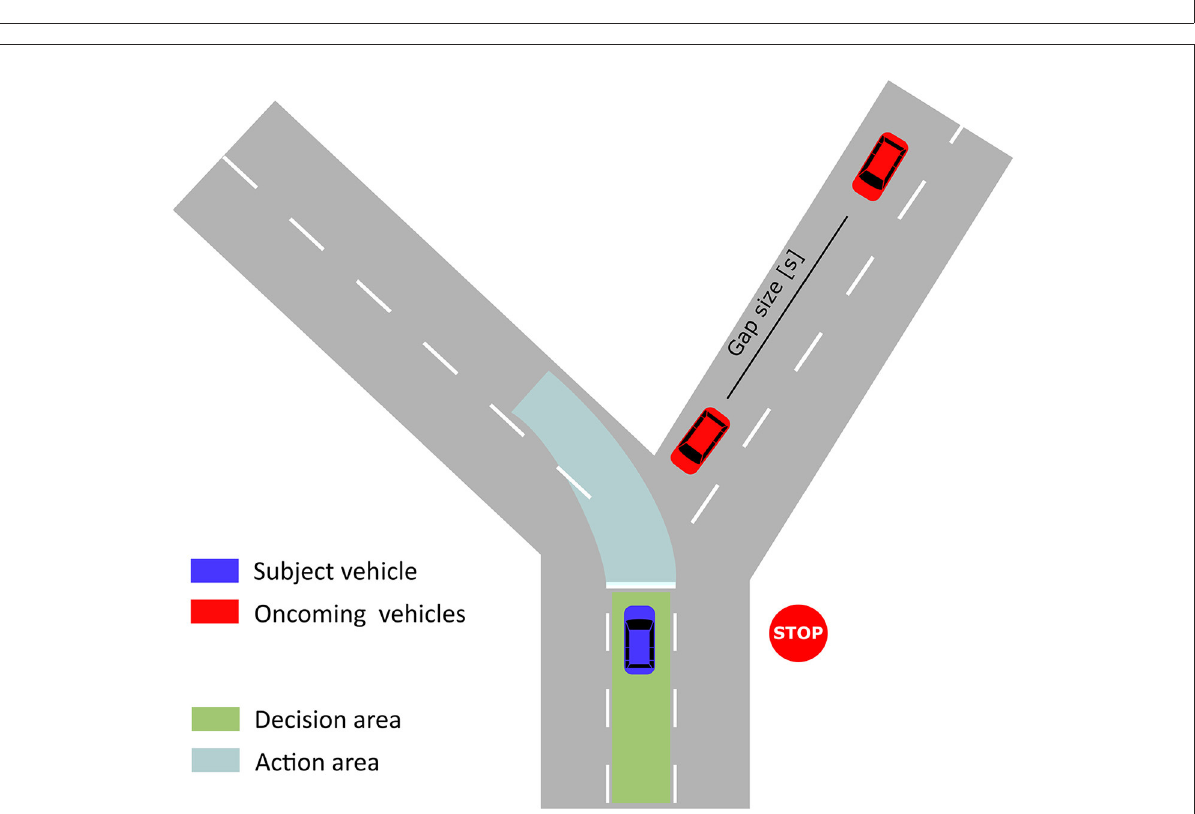
FIGURE2 Sketch of intersection. The gap size between two oncoming vehicles is defined as the time that passes after the first oncoming vehicle has crossed the intersection until the second vehicle has crossed the intersection.